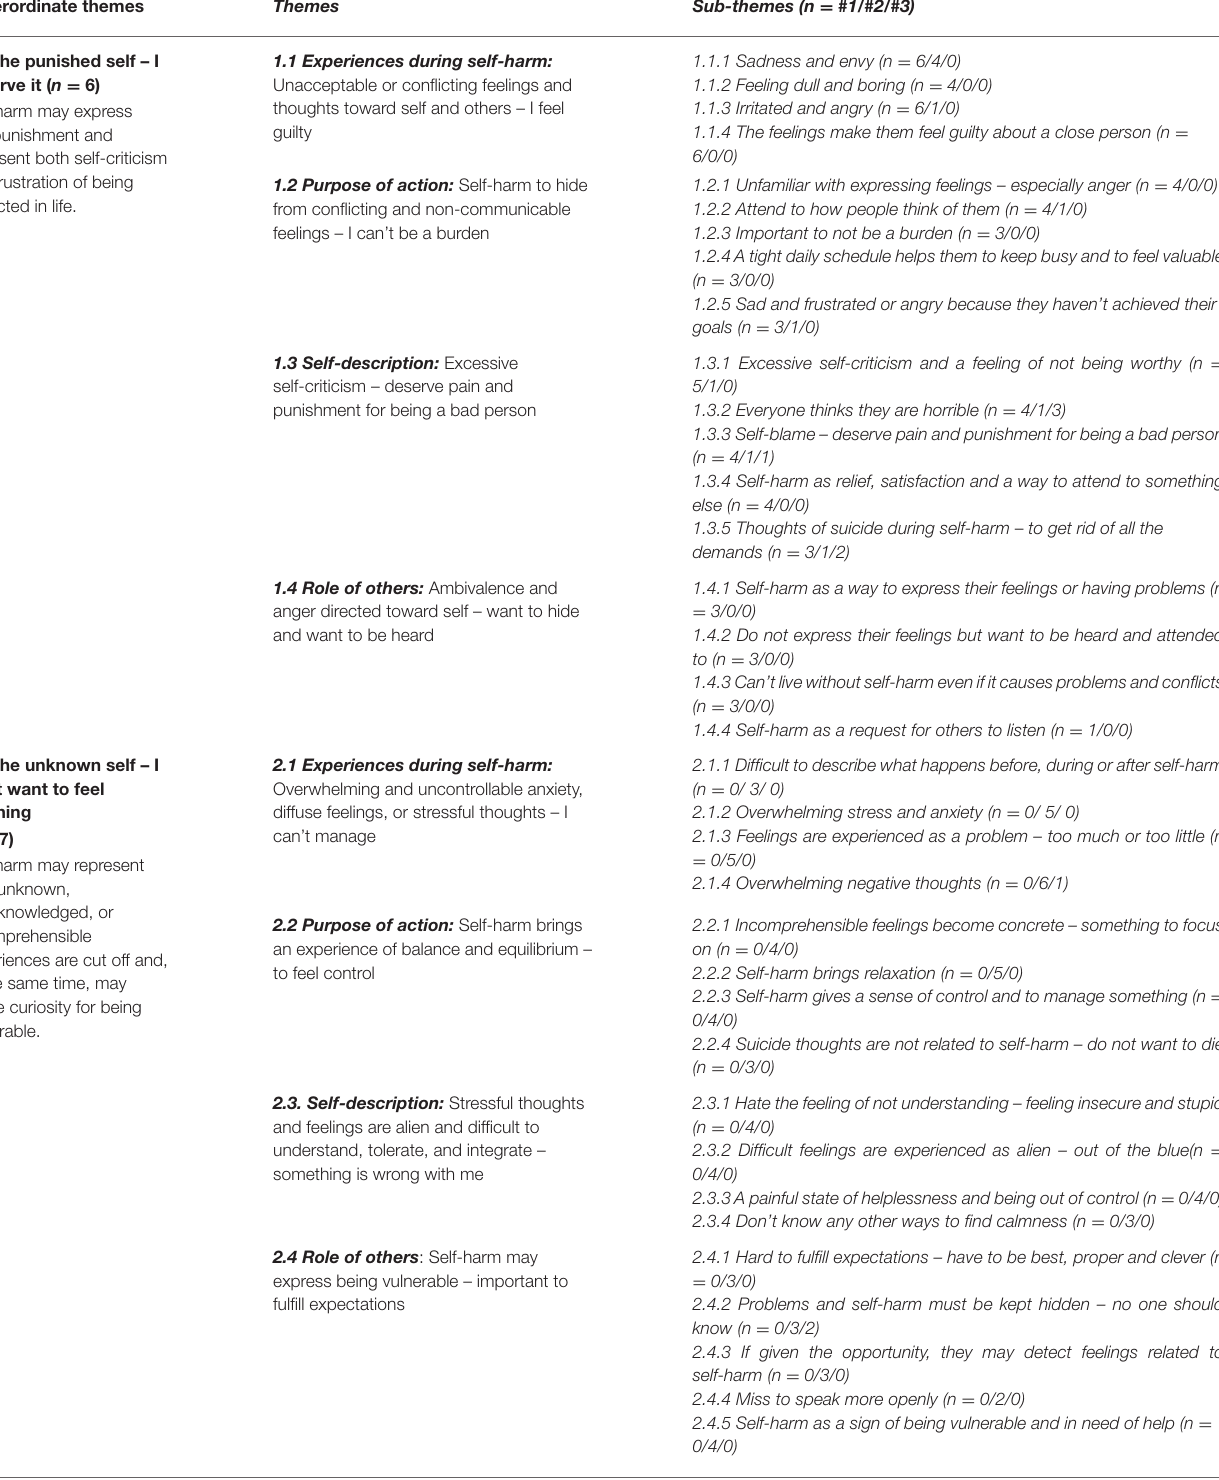
TABLE 1 | Three superordinate themes with associated themes and sub-themes. Superordinate